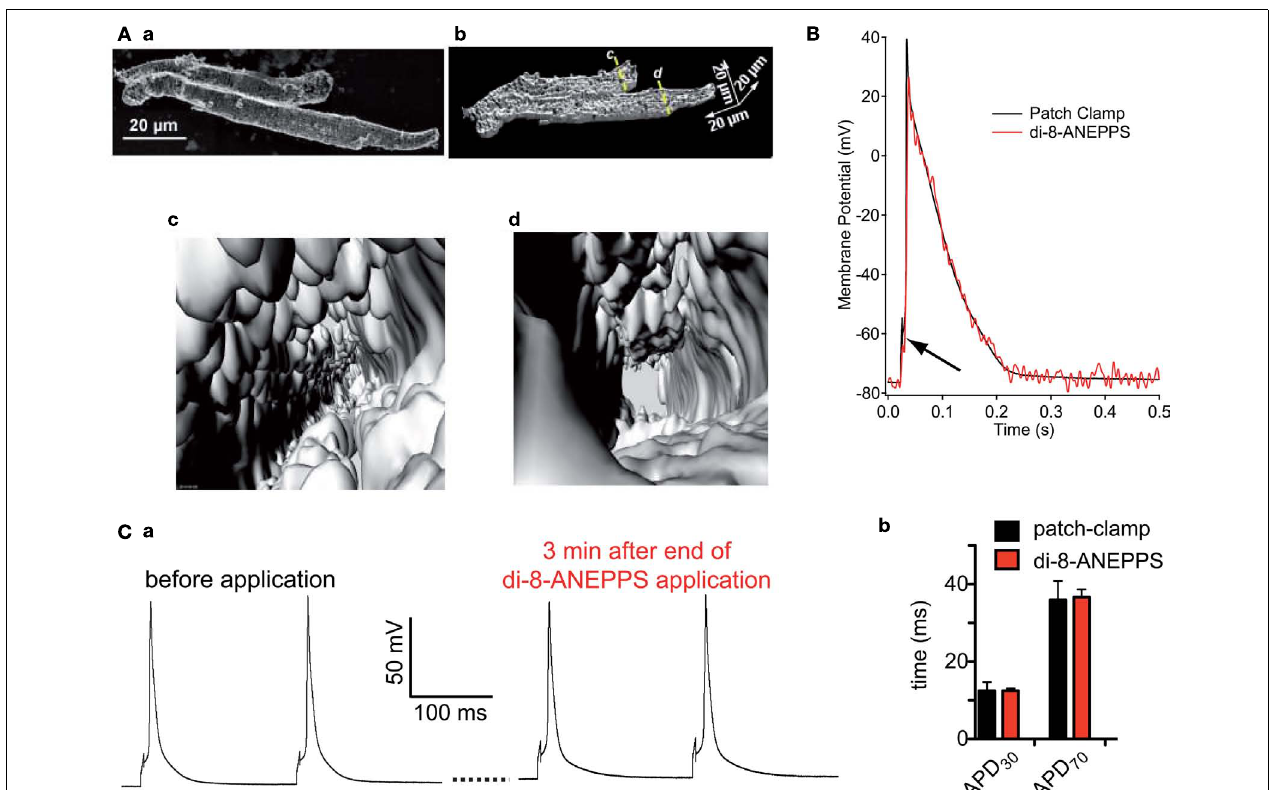
technique to induce an action potential translates into the optical signal (black arrow). (C) Shows that the di-8-ANEPPS, when applied at a concentration of 5 μ M for 7min, does not disturb the naive action potential. (a) Displays action potentials recorded by patch-clamp before and after the di-8-ANEPPS staining procedure. (b) Depicts a statistical analysis of action potential duration in cells measured by the patch-clamp technique ( n = 94) and measured by the optical di-8-ANEPPS read out ( n = 214). (B,C) are reproduced fromTian et al. (2011) with friendly permission of S. Karger AG (Basel,